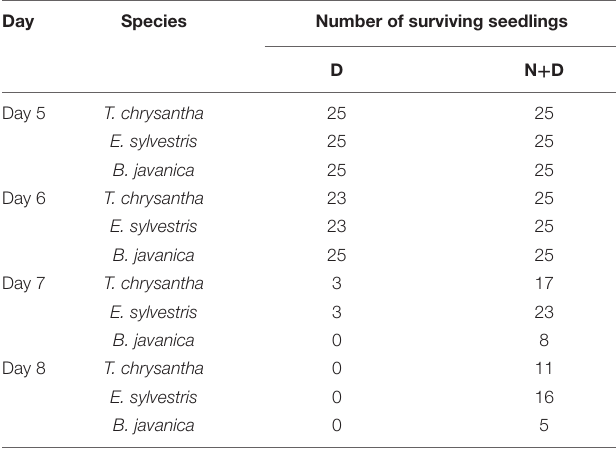
TABLE 3 | Number of surviving seedlings of each species in the drought stress (D) group and drought plus nitrogen addition (N + D) group in this experiment (During the experiment, only seedling death occurred in these two